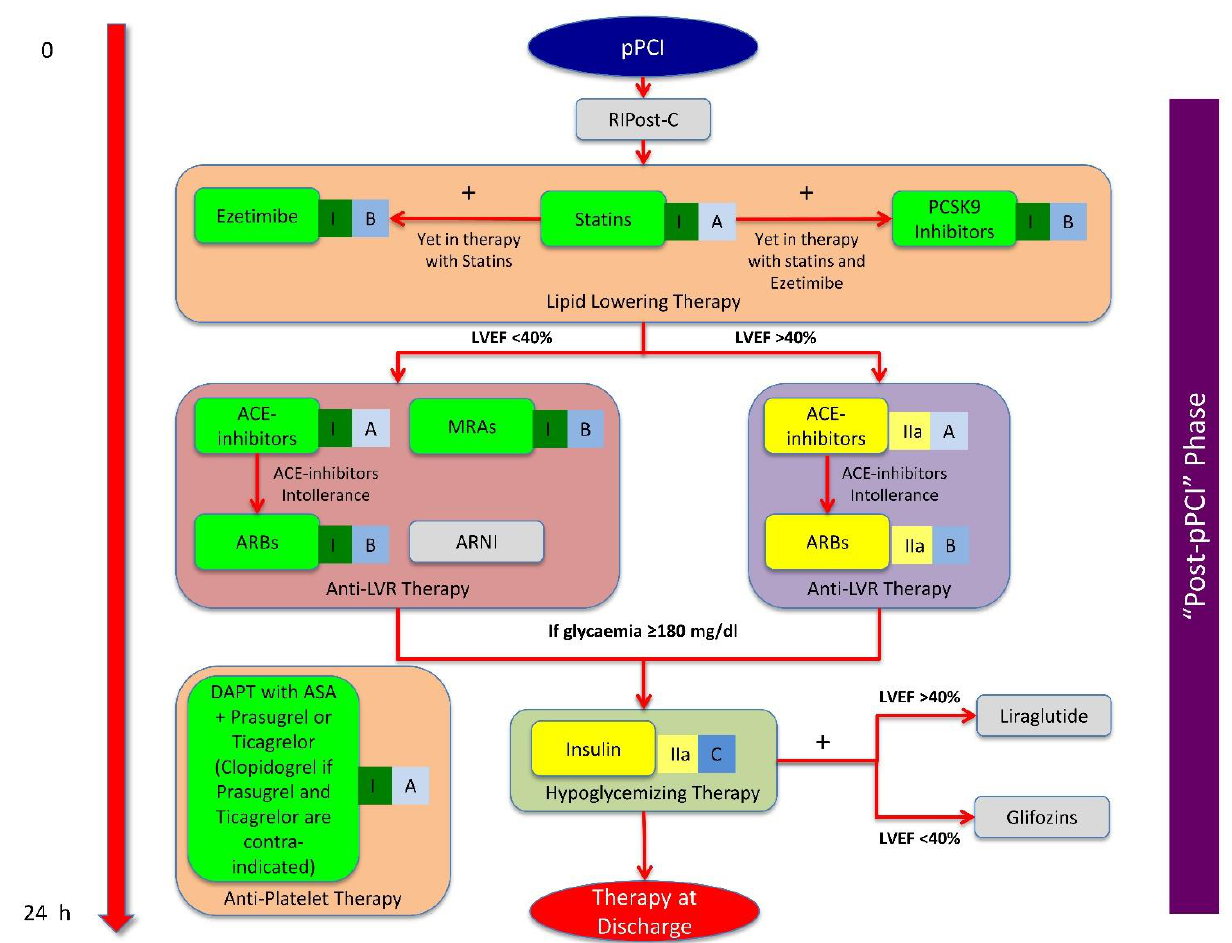
Figure 4. Scheme for a reasoned multitarget therapeutic strategy against post-STEMI LVR in the ‘ post-pPCI ’ phase. In this picture, the timing of conventional pharmacological therapy for STEMI patients, in the ‘ post-pPCI ’ phase is described, according to the European Society of Cardiology (ESC) guidelines. Each pharmacological indication is identified with its own class of recommendation and level of evidence. In the gray rectangles, the perspective pharmacological therapies (ARNI, liraglutide, glifozins) and mechanical interventions (RIPost-C) in order to further improve protection against post-STEMI LVR according to precise timing are identified. STEMI: ST elevation myocardial infarction; pPCI: primary percutaneous intervention; LVR: left ventricular remodeling; ARNI: angiotensin receptor neprilysin inhibitor; RIPost-C: remote ischemic post-conditioning; PCSK9: proprotein convertase subtilisin/kexin type 9; ARBs: angiotensin receptor blockers; MRAs: mineralocorticoid receptor antagonists; DAPT: dual anti-platelet therapy; ASA: acetylsalicylic acid; LVEF: left ventricular ejection fraction.